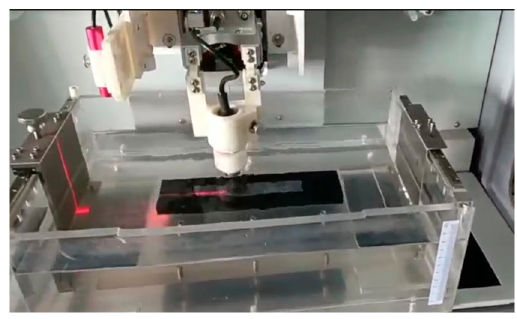
Figure 6. Water immersion ultrasonic testing system.